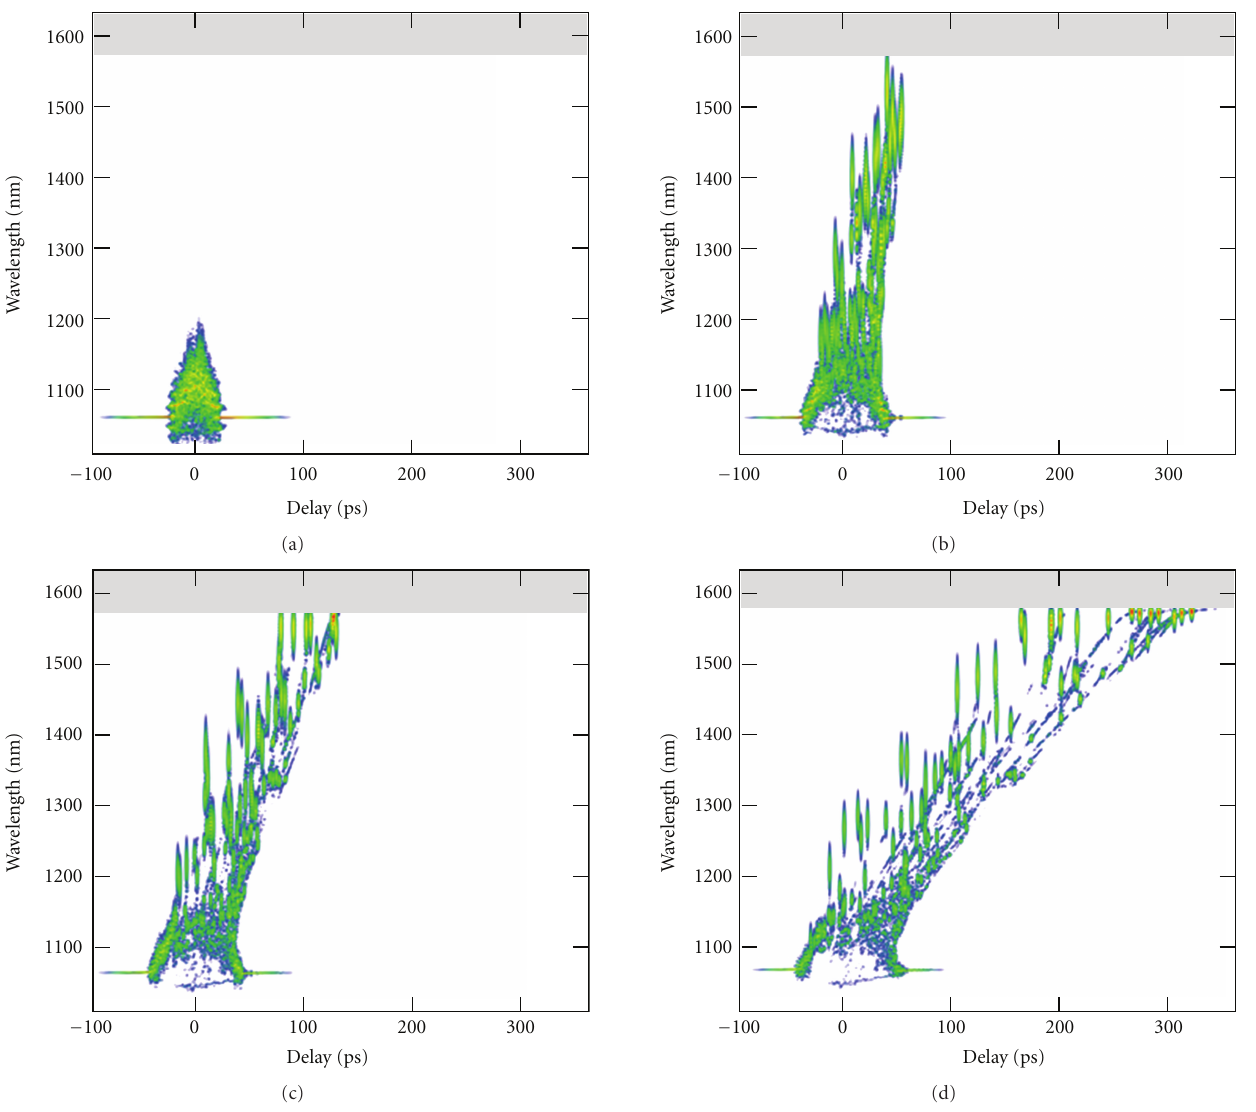
Figure 13: Simulated spectrograms representing the spectrotemporal dynamics of the SC generation for four propagation distances z of 1, 2.5, 4, and 7 m, respectively, from (a) to